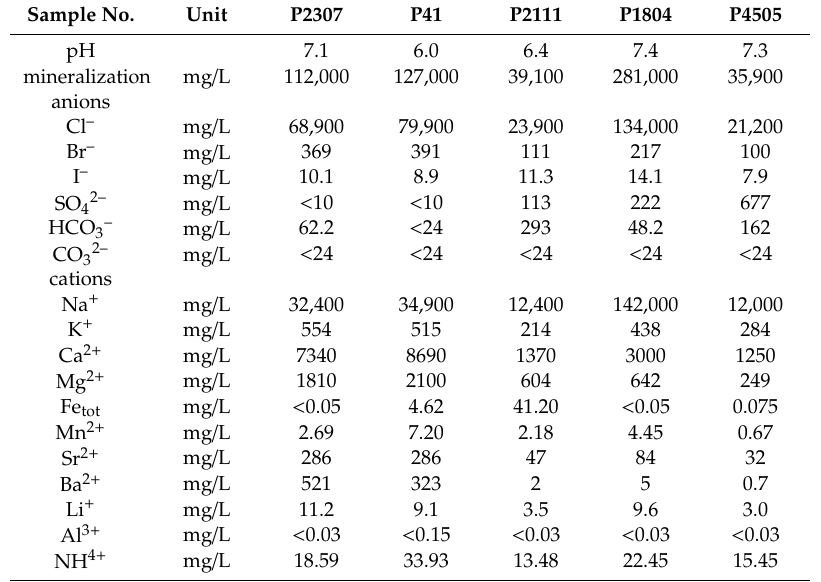
Table 5. Geochemical composition of the selected mine waters from the ˇCSA Mine, Doubrava Shaft. Sample